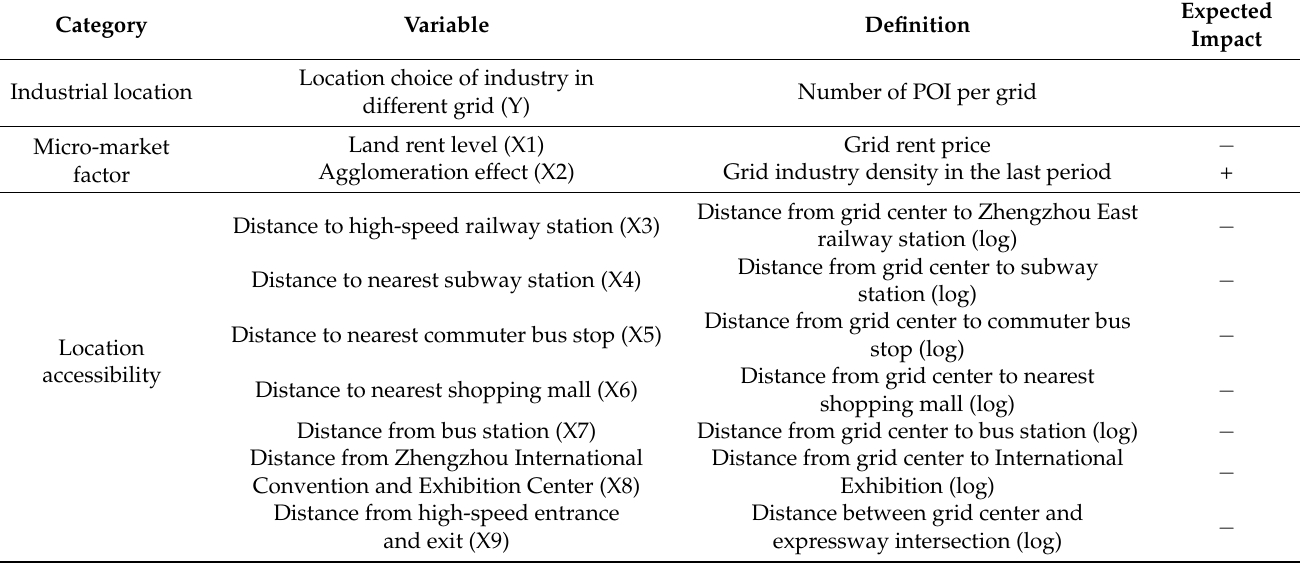
Table 1. Factors and explanation of industrial location selection of Zhengzhou East railway